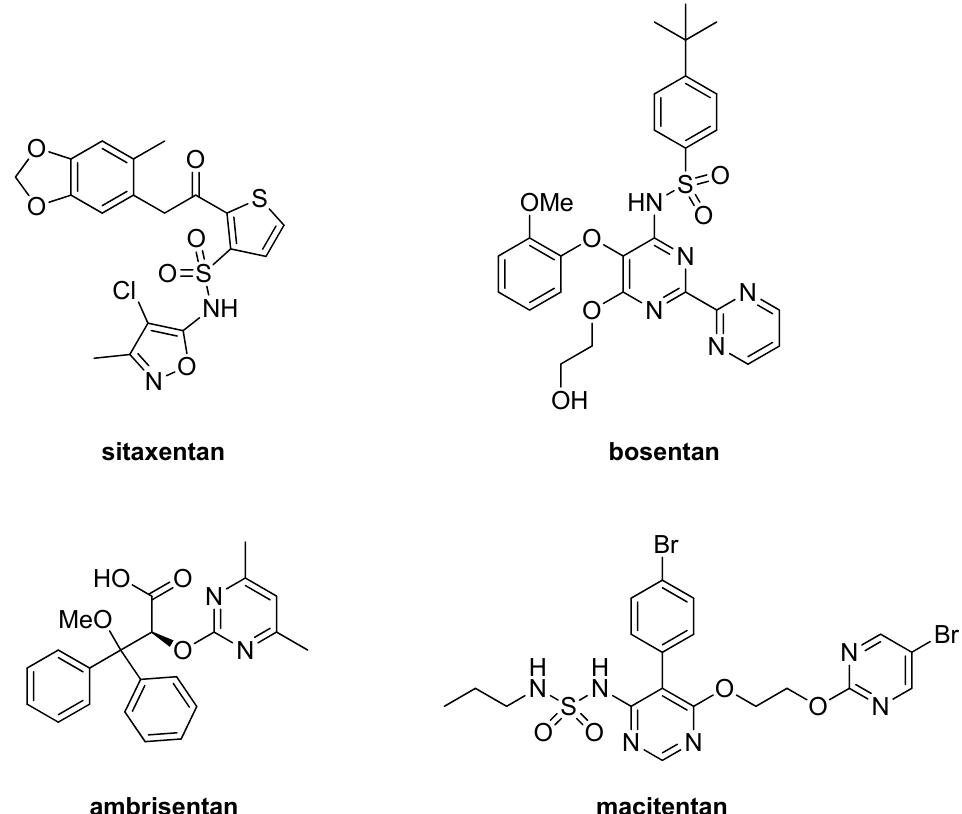
Figure 1. Marketed Endothelin (ET) antagonists.